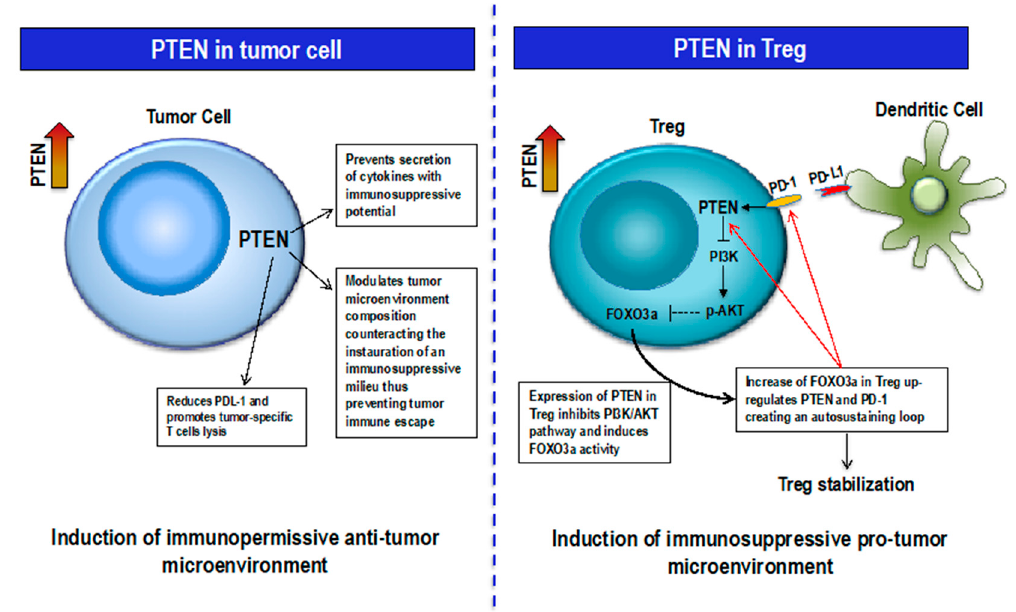
Figure 2. Context-dependent PTEN function. Left, PTEN expression in Tumor cells modulates microenvironment composition with anti-tumor effect; right, PTEN-FOXO3a-PD-1 feedback loop in Treg increases Treg stability thus supporting an immunosuppressive pro-tumor microenvironment.